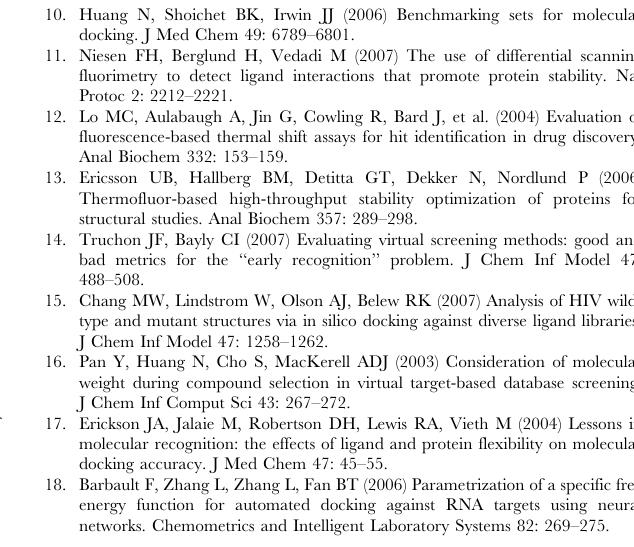
Figure S1 Distribution of rotatable bonds in NCI Diversity Set II and DUD compounds. Figure S2 Distribution of sizes for largest clusters in AD4 results. Each compound was docked in 100 independent AD4 runs, then clustered based on conformation, serving as an indication of the level of convergence of the docking results.